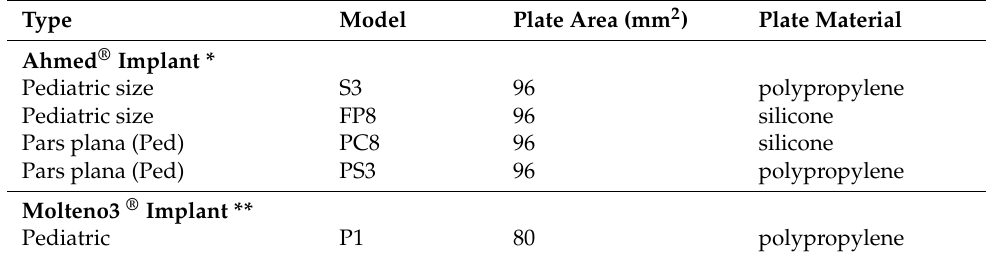
Table 4. Main Glaucoma Drainage Devices available for pediatric